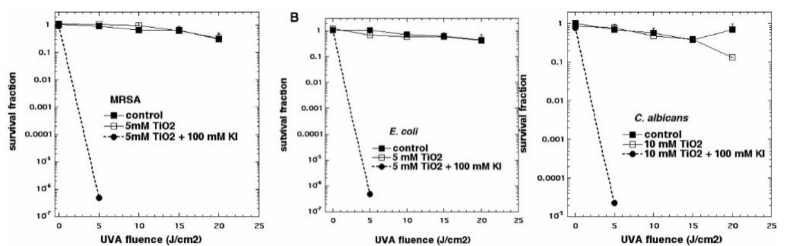
Figure 7. Titanium dioxide photocatalysis is potentiated by potassium iodide. ( A ) MRSA; ( B ) E. coli ; ( C ) C. albicans . Figure adapted from data contained in [24].